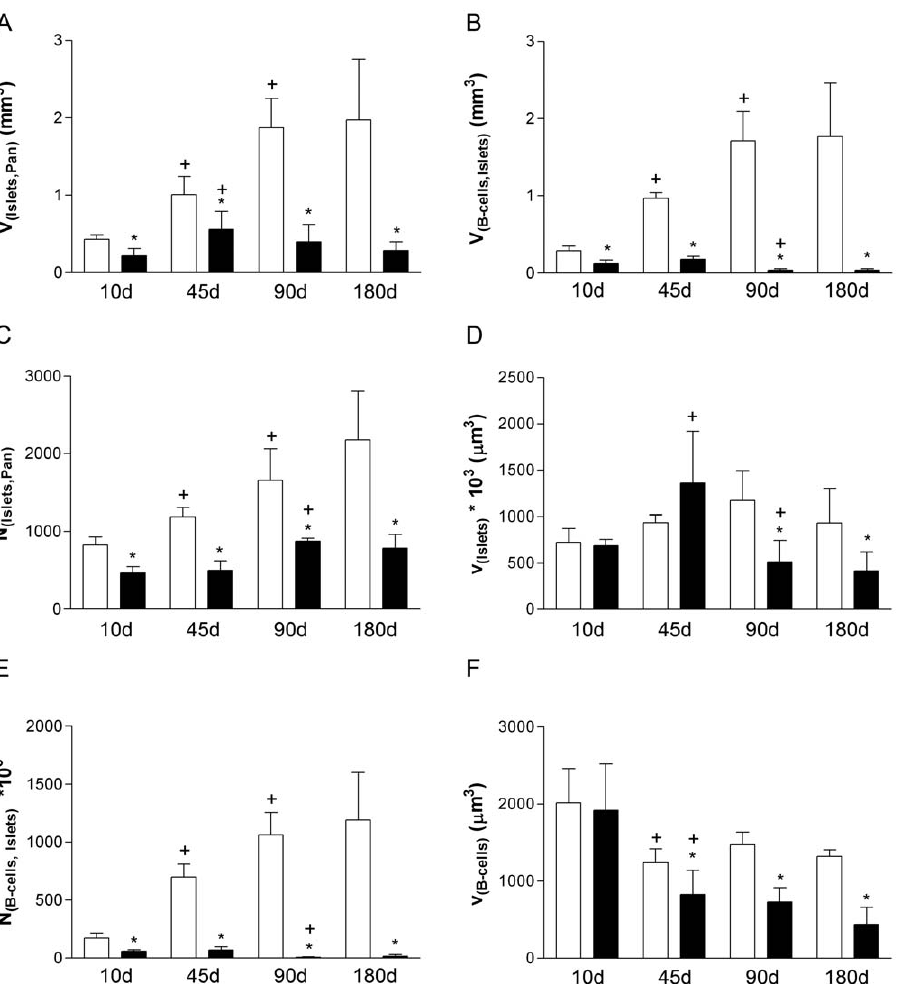
Figure 2. Quantitative-stereological investigations of the endocrine pancreas. (A) Total islet volume (V (Islets,Pan) , (B) total beta-cell volume (V (B-cells,Islets) , (C) Number of islets (N (Islets, Pan) , (D) mean islet volume (v (islets) , (E) beta-cell number (N (B-cells,Islets) , (F) mean beta-cell volume (v (B-cells). Open bars: female control mice; filled bars: female GIPR dn transgenic mice; Data represent means and SEM. * p , 0.05 vs. age-matched control; + p , 0.05 vs. previous time point.